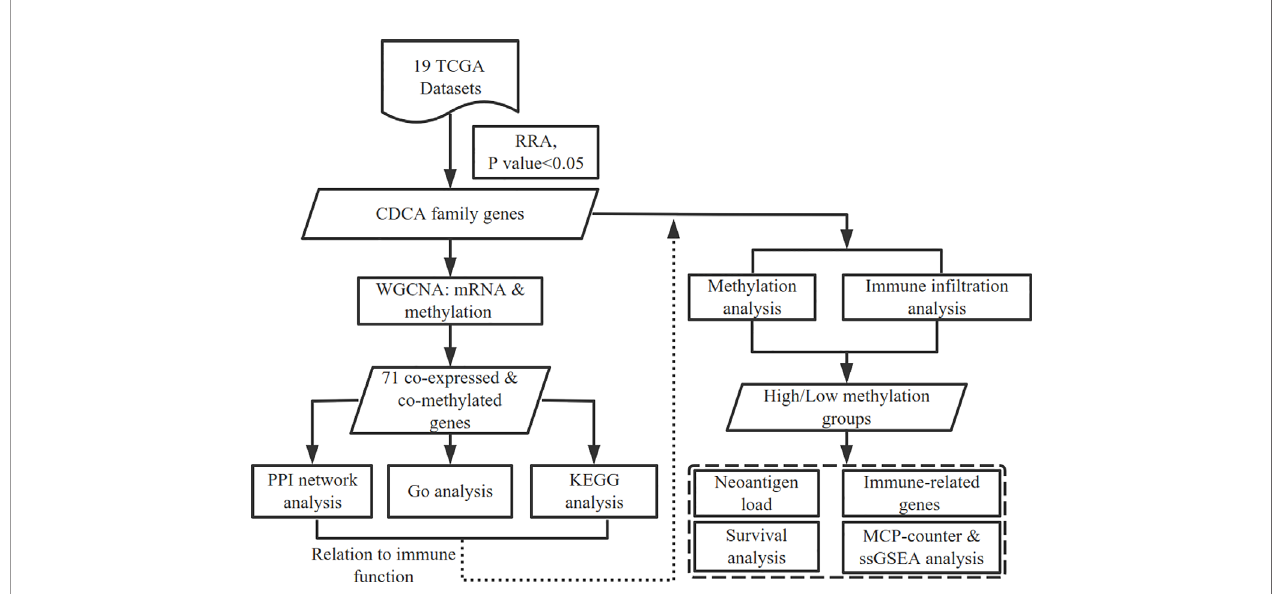
FIGURE 1 | Work fl ow of this study. The high and low methylation groups are classi fi ed by the median methylation levels of